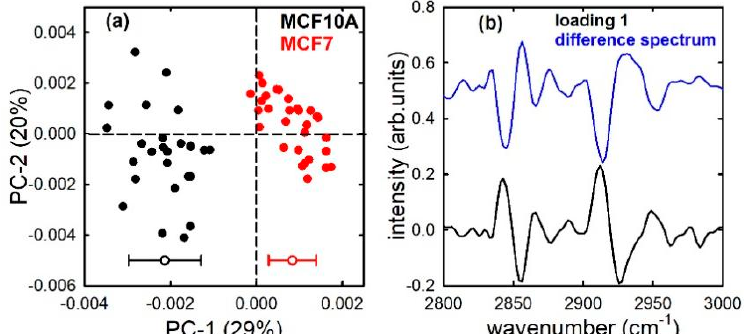
Figure 3. PC1 and PC2 score plot ( a ) for the MCF10A (black dots) and MCF7 (red dots) cells; average ( − 0.0021 and +0.0008 for MCF10A and MCF7, respectively) and standard deviation (0.0008 and 0.0005 for MCF10A and MCF7, respectively) of the PC 1 distribution values are shown at the bottom of ( a ). Loading 1 spectrum (black line), compared with the difference between average spectra (blue line), is reported in ( b ).